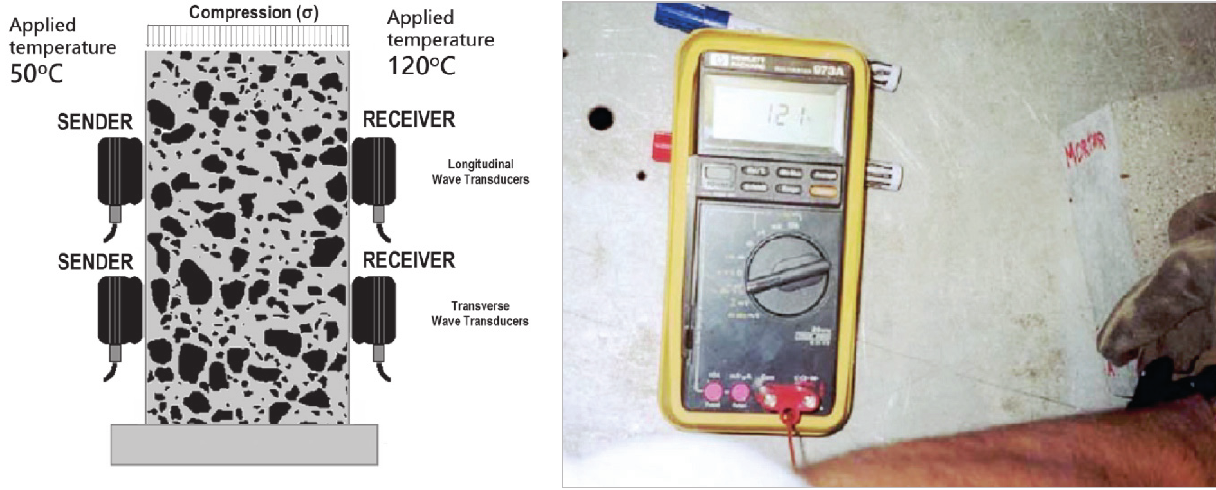
Schematic representation of the applied thermal loading (50ºC on the left-hand side and 120ºC on the right-hand side of the specimen), transducers positions, and compression load (figure on the left). Application of the thermal loading and temperature readings at one of the specimens (photograph on the